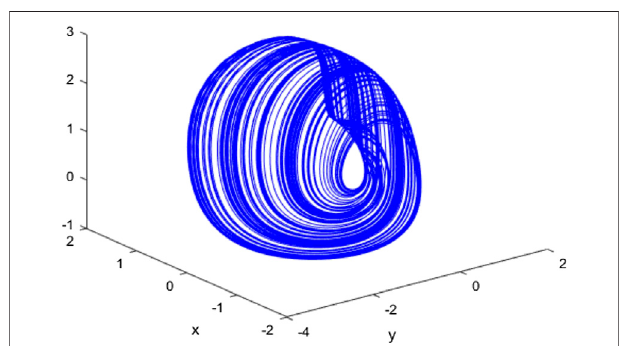
FIGURE 4 | 3D diagram of the memristive chaotic system Eq. 11